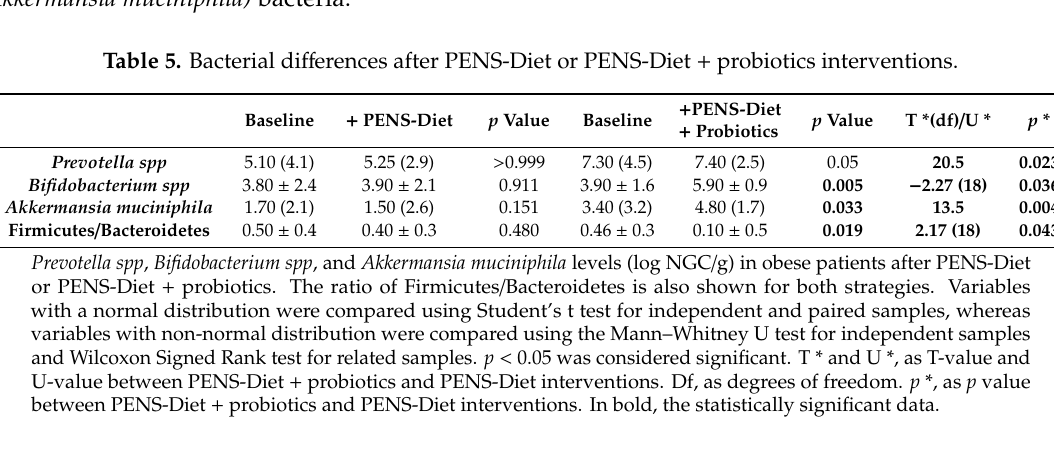
Table 5. Bacterial di ff erences after PENS-Diet or PENS-Diet + probiotics interventions. Baseline + PENS-Diet p Value Baseline Prevotella spp 5.10